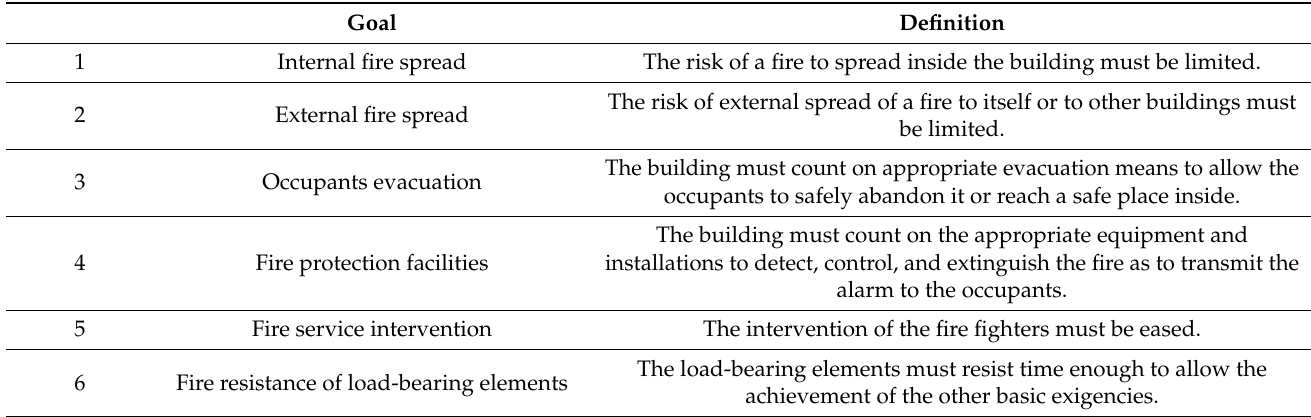
Table 12. Definitions of the particular goals laying out the fire safety general goal. (Source: CTE. Translated by the authors).